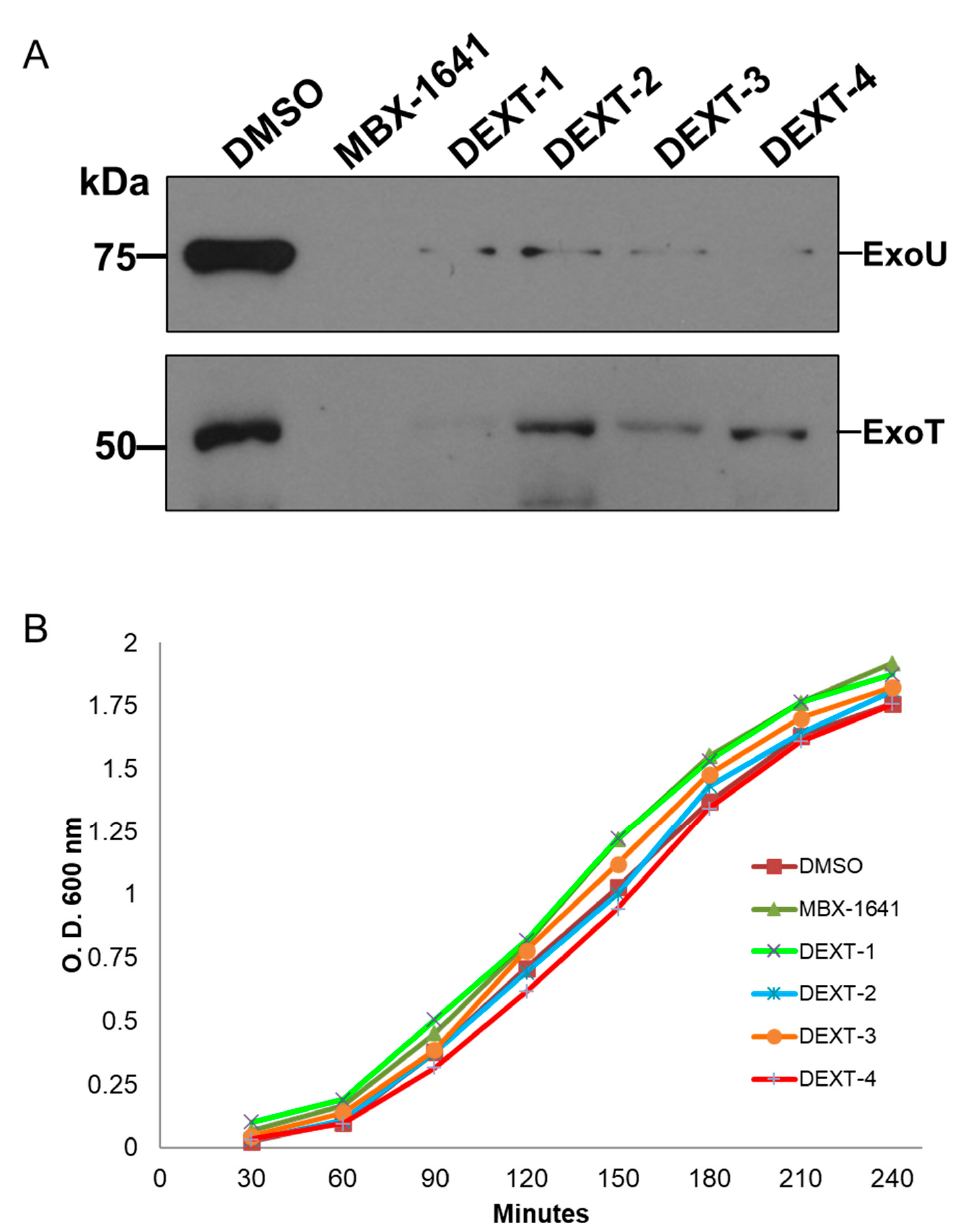
Figure 4. ( A ) Inhibition of the secretion of the effector proteins ExoU and ExoT by MBX-1641 (a T3SS inhibitor used as positive control) and the pyrrolidones DEXT 1–4 [100 µM]. Secreted proteins were immunodetected using specific antibodies against ExoU and ExoS (the ExoS polyclonal antibodies cross-react with ExoT). Control: DMSO ( B ) Growth curve showing no effect of MBX-1641 or DEXT 1–4 on the viability of P. aeruginosa PA14 WT. Control: DMSO.